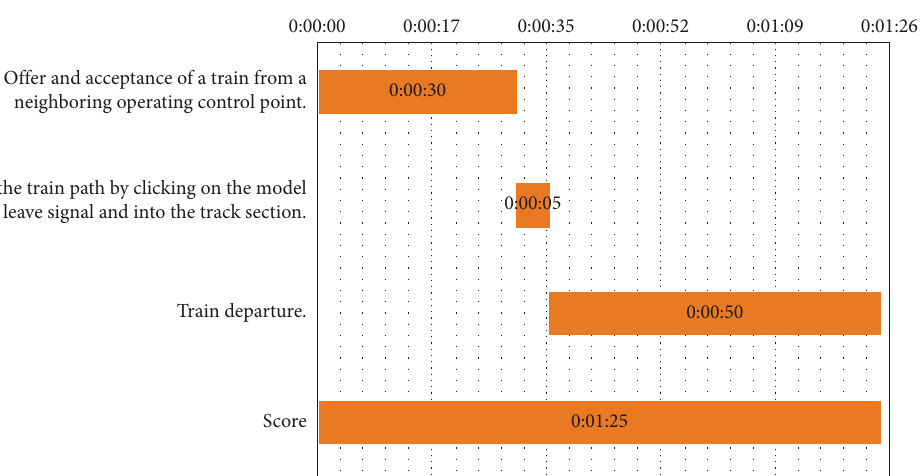
Figure 8: Preparing the departure train path on the electronic signal